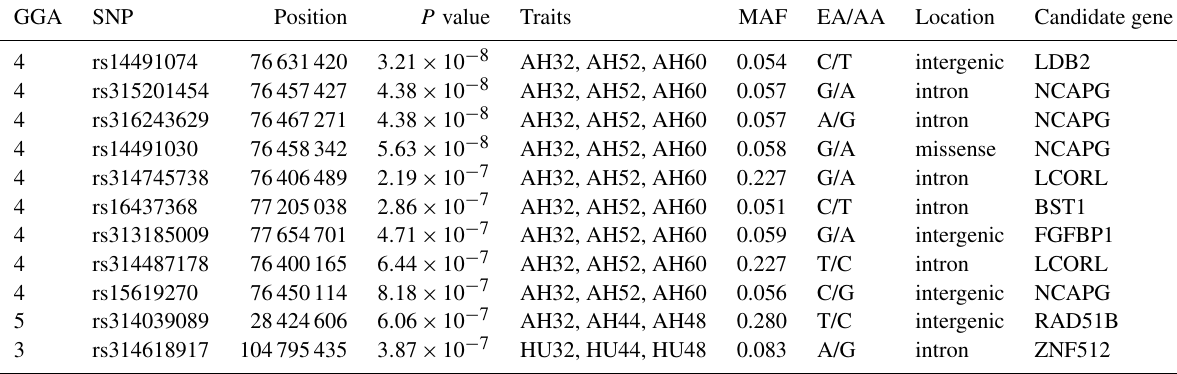
Table 5. Eleven SNP markers with significant effects on albumen quality by multivariate analysis. GGA